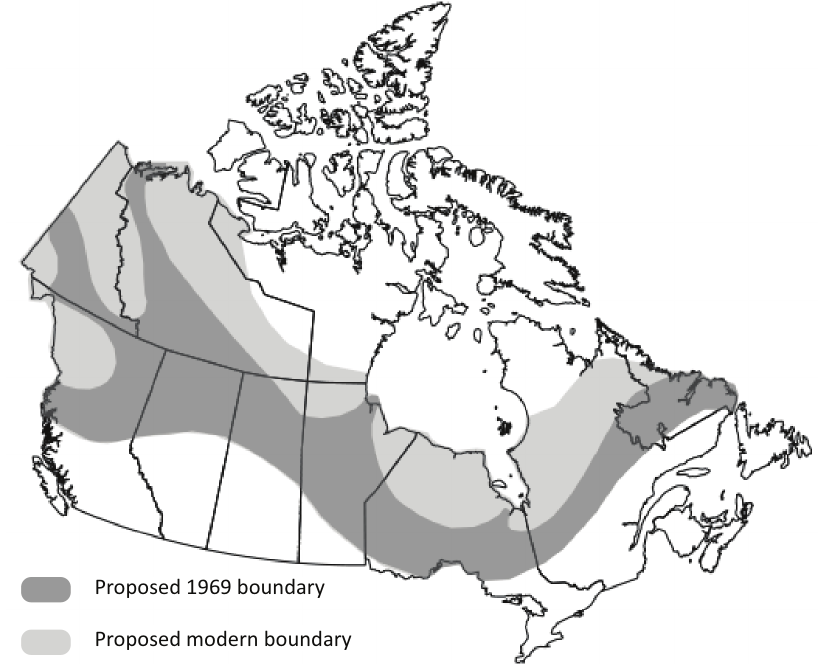
Figure 1. Mid-Canada Corridor. Diagram of Canada adapted from the 1969 concept of the Mid-Canada Corridor (Rohmer, 1969) and its modern re-imagining to include newly discovered resource rich areas (Van Nostrand,